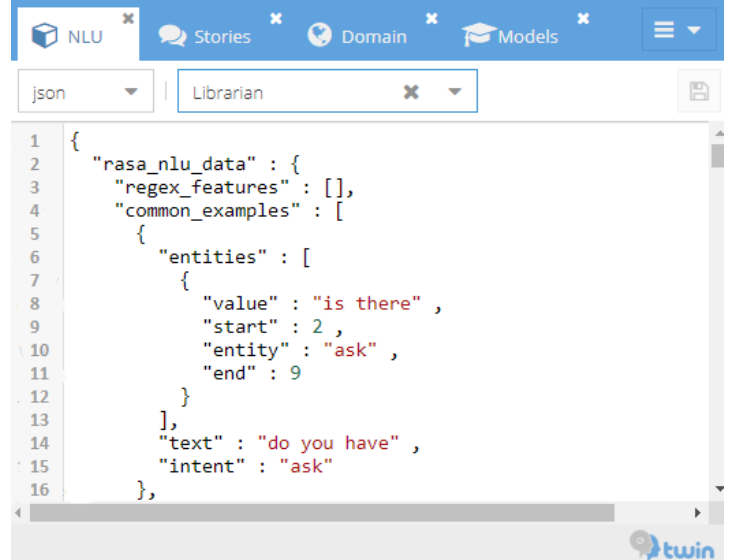
Fig. 5. Synonyms directory.